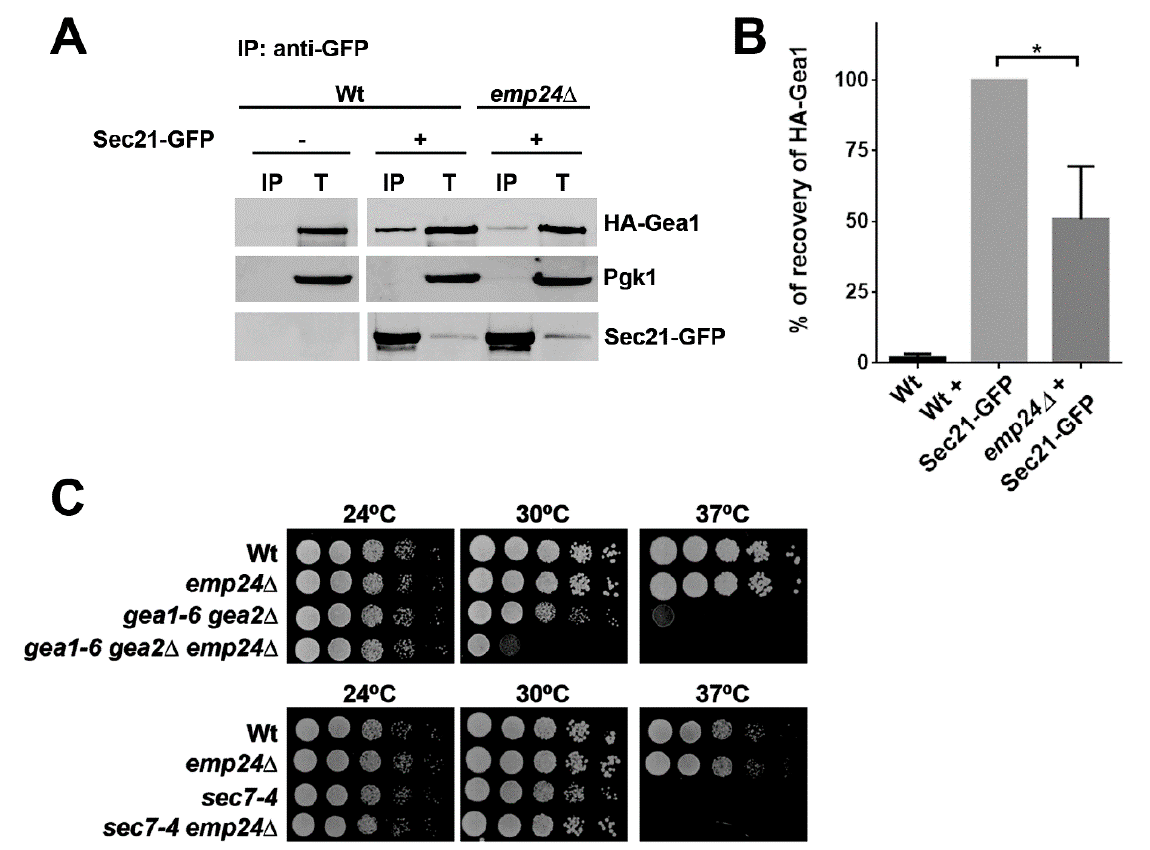
Figure 4. The Gea1/COPI coat complex is stabilized by the p24 complex. ( A ) The p24 complex is required for the efficient interaction between Gea1 and the COPI coat. Detergent-solubilized S13 fractions of wild-type and emp24 ∆ mutant cells expressing HA-Gea1 and the COPI coat subunit Sec21-GFP were subjected to native immunoprecipitation (IP) with anti-GFP antibody, followed by immunoblotting. Total (T) represents a fraction of the solubilized input material. ( B ) Quantification of three independent experiments. The graph plots the average percentage of the recovery of HA-Gea1 normalized to the recovery in the wild-type strain. Error bars indicate the SD. Statistical significance was determined by using the Student t test. * p < 0.05. ( C ) The loss of the p24 complex intensifies the thermosensitive growth defect in the gea1-6 gea2 Δ double mutant but not in the sec7-4 mutant strain. Cells were tested for growth at 24, 30 and 37 °C on YPUAD.